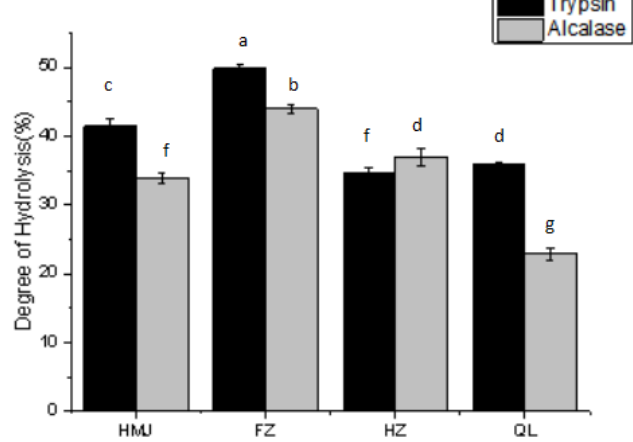
Fig. 2: Degree of hydrolysis (DH, %) for four kinds of dark tea generated by trypsin and Alcalase and their complete protein extracts. Mean ± SD (n=4). Bars with different letters are significantly different at p <